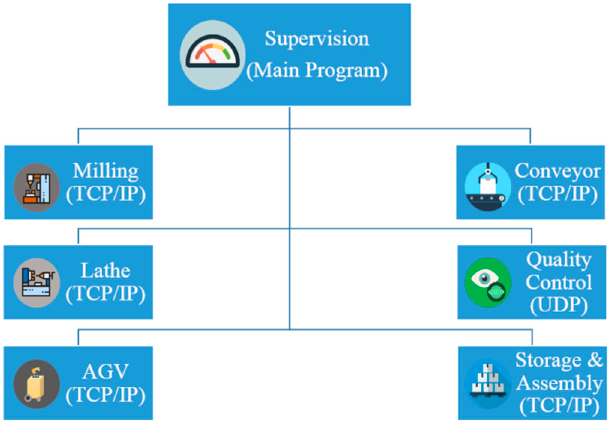
Figure 2. Manufacturing cell stages.